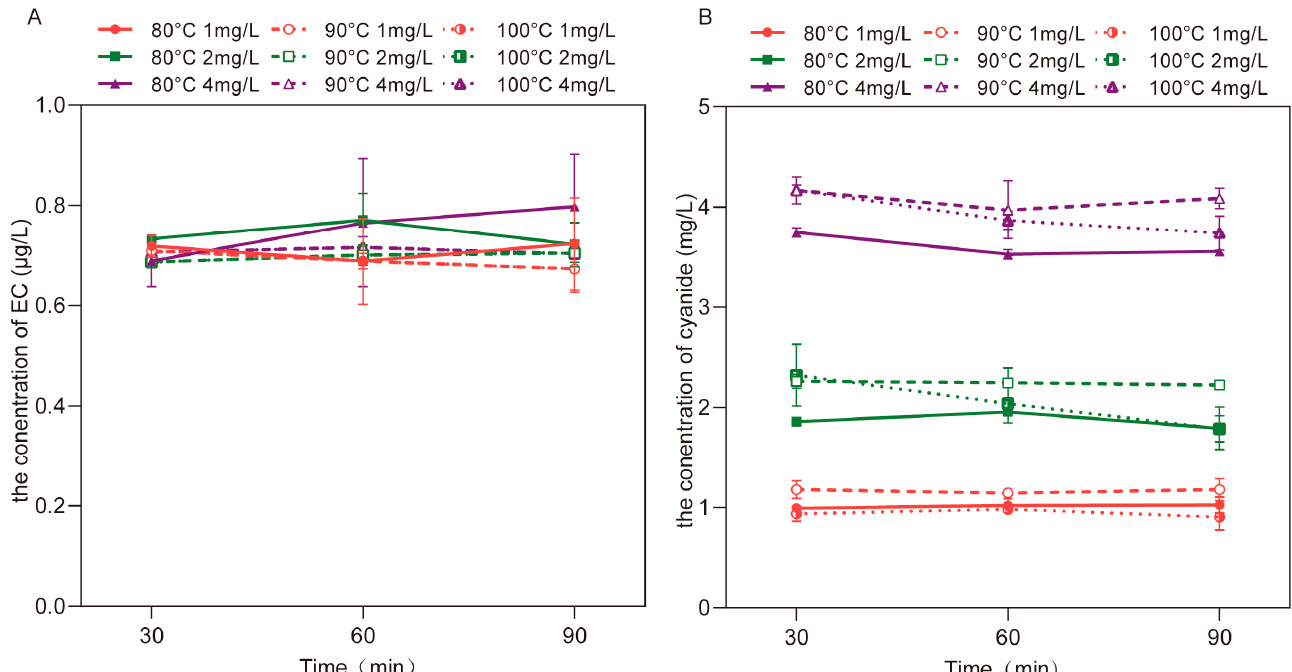
Figure 5. The concentrations of EC ( A ) and cyanide ( B ) during aqueous reactions between cyanide (1.0, 2.0 and 4.0 mg/L) and ethanol (2%) at 80 °C, 90 °C and 100 °C, respectively.